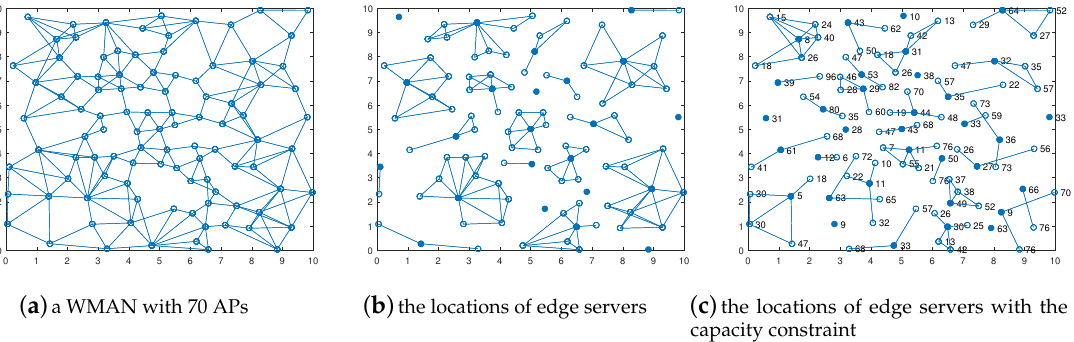
Figure 3. An example for ESPPOC and ESPPWC